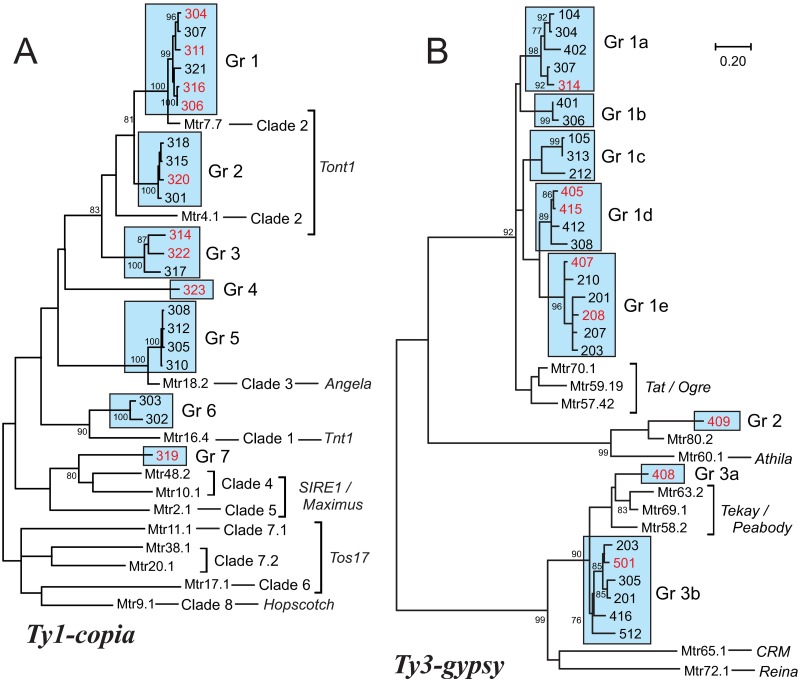
Phylogenetic trees of reverse transcriptase sequences.Trees show the relationships between lentil sequences and Medicago truncatula (Mtr) sequences. A, Ty1-copia sequences; B, Ty3-gypsy sequences. Lentil sequences are within boxes indicating the different linkage groups (Gr) to which they belong, groups were related to the M. truncatula clades as described by Piednöel et al. [46] and the M. truncatula sequence numbers as in Wang and Liu [44]. Red color denotes the presence of premature stop codons in the reading frames.